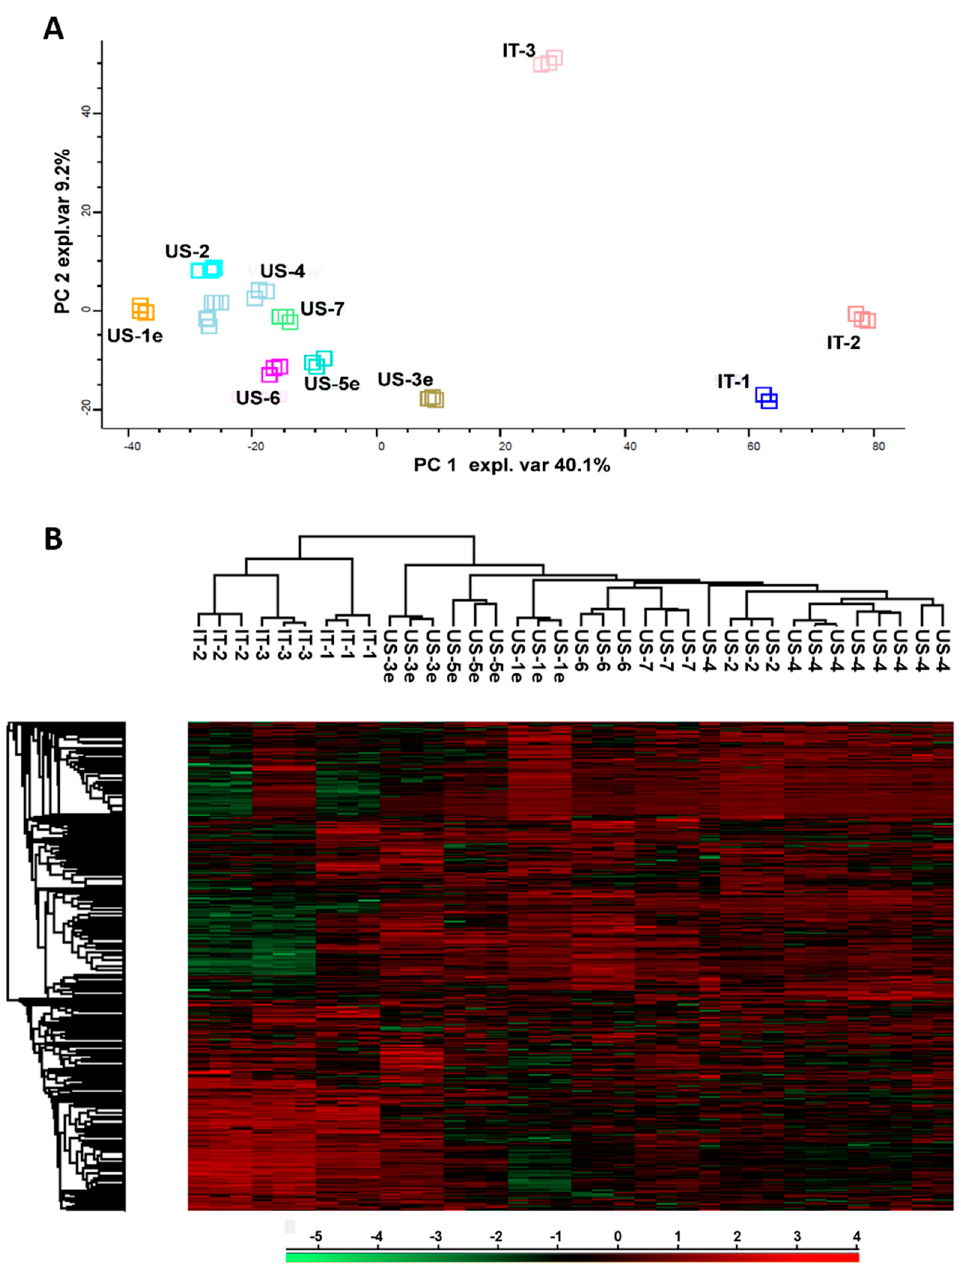
Figure 2. ( A ) Principal component analysis of quantified proteins highlighted in VSL#3 products. ( B ) Unsupervised hierarchical clustering of proteins identified in VSL#3 products by LC-MS/MS performed with Perseus software.